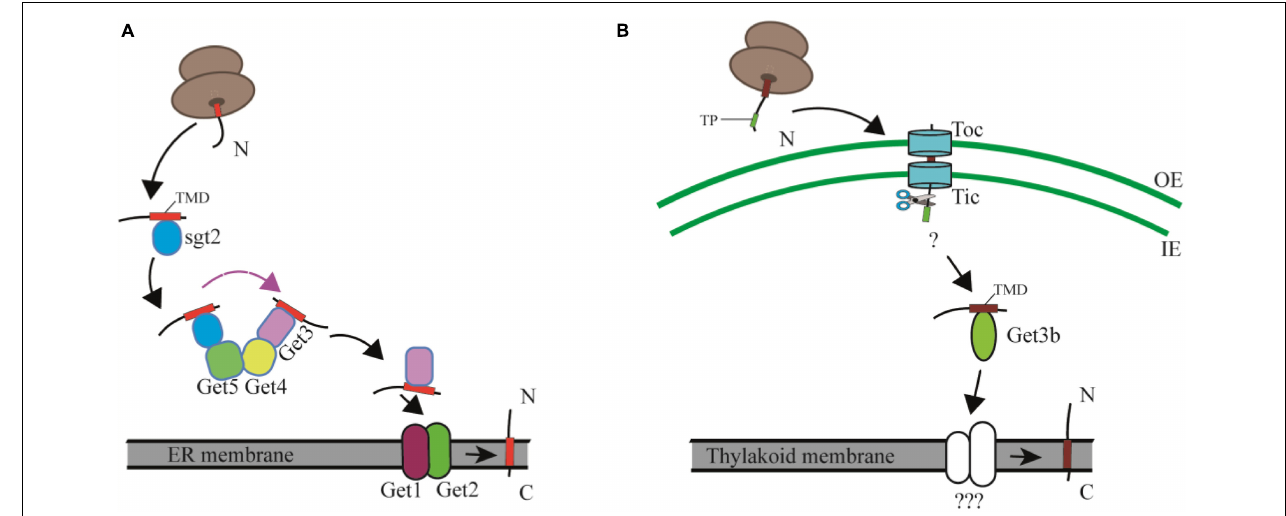
FIGURE 3 | Comparison of the cytosolic and chloroplast GET pathway. (A) In the cytosolic GET pathway, the newly synthesized TA proteins are firstly captured by Sgt2, and then transferred to the targeting factor Get3 by the Get4/Get5 scaffold complex, and finally integrated into ER membranes with the facilitation of Get1 and Get2. TMD, transmembrane domain. (B) In the cpGET pathway, imported TA proteins are transferred to the targeting factor Get3b, and then integrated into the thylakoid membrane with the aid of unknown integrases. OE, outer chloroplast envelope; IE, inner chloroplast envelope. TP, transit peptide. TMD, transmembrane